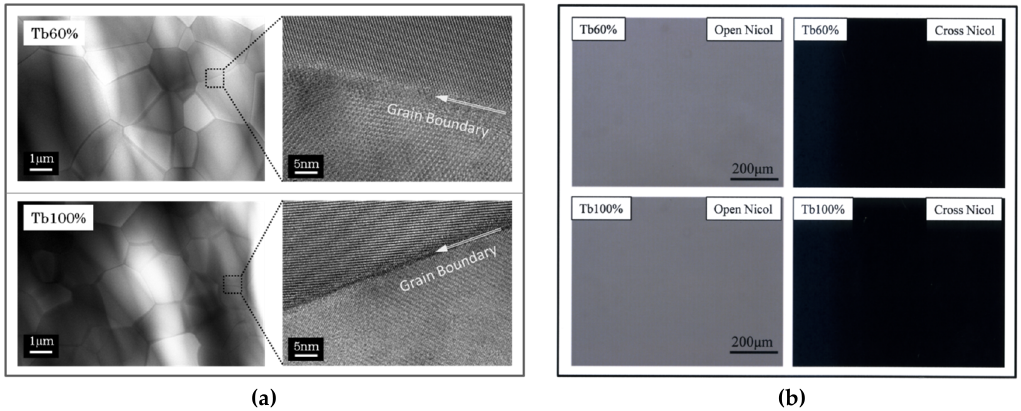
Figure 2. ( a ) The microstructure of (Tb 0.6 Y 0.4 ) 2 O 3 and Tb 2 O 3 ceramics after HIP treatment as